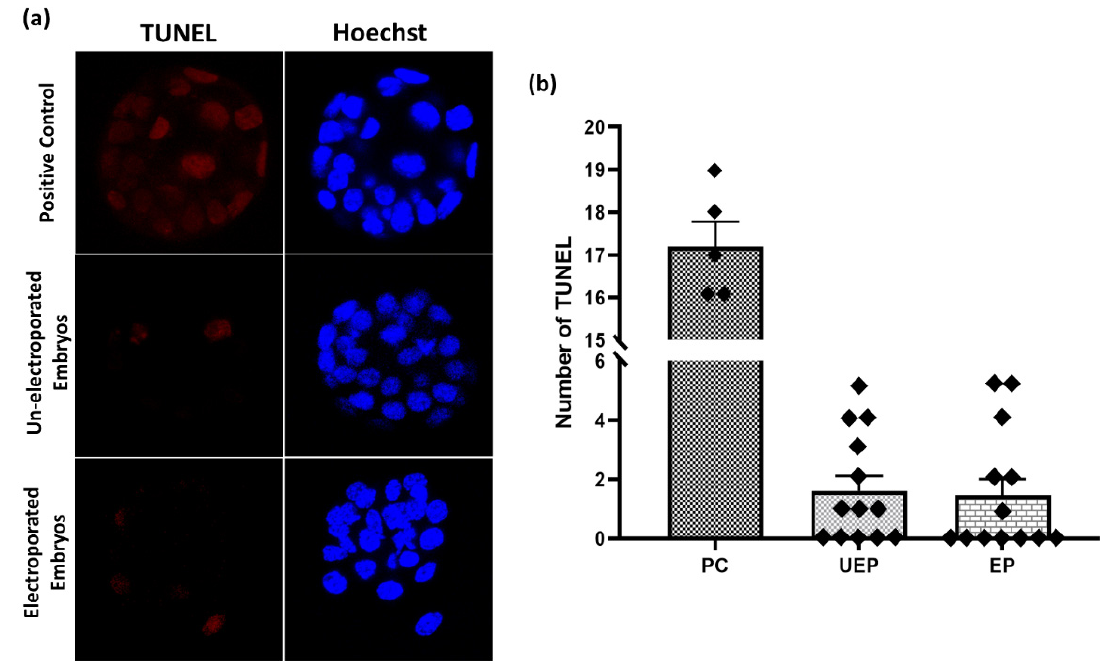
Figure 6. Assessment of in vitro embryonic development after the GFP electroporation through the TUNEL assay. Apoptotic nuclei in un-electroporated (UEP) vs. electroporated (EP) mouse embryos were observed by TUNEL assay, which labels the fragmented DNA. ( a ) Confocal microscopy showed no apparent difference in apoptotic nuclei (red) between electroporated and un-electroporated blastocysts. Positive control blastocysts were TUNEL-labeled after DNase treatment. Nuclei were stained with Hoechst 33342 (blue) in all groups. ( b ) Apoptotic nuclei number in each blastocyst. Original magnification of photomicrographs was ×400.